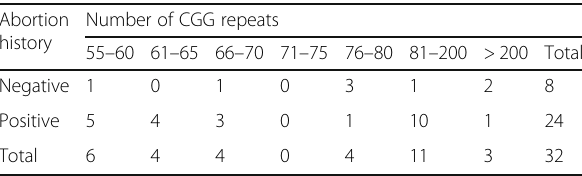
Table 1 Distribution of CGG repeat number in the 29 pre-mutation carriers and 3 full mutation carriers Abortion